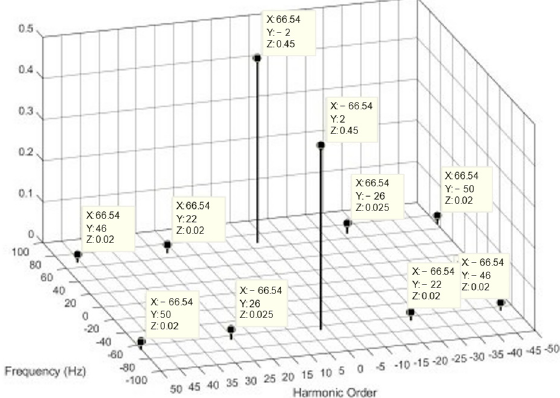
Figure 10. 2-D FFT results of magnetic flux density at 2000 rpm.